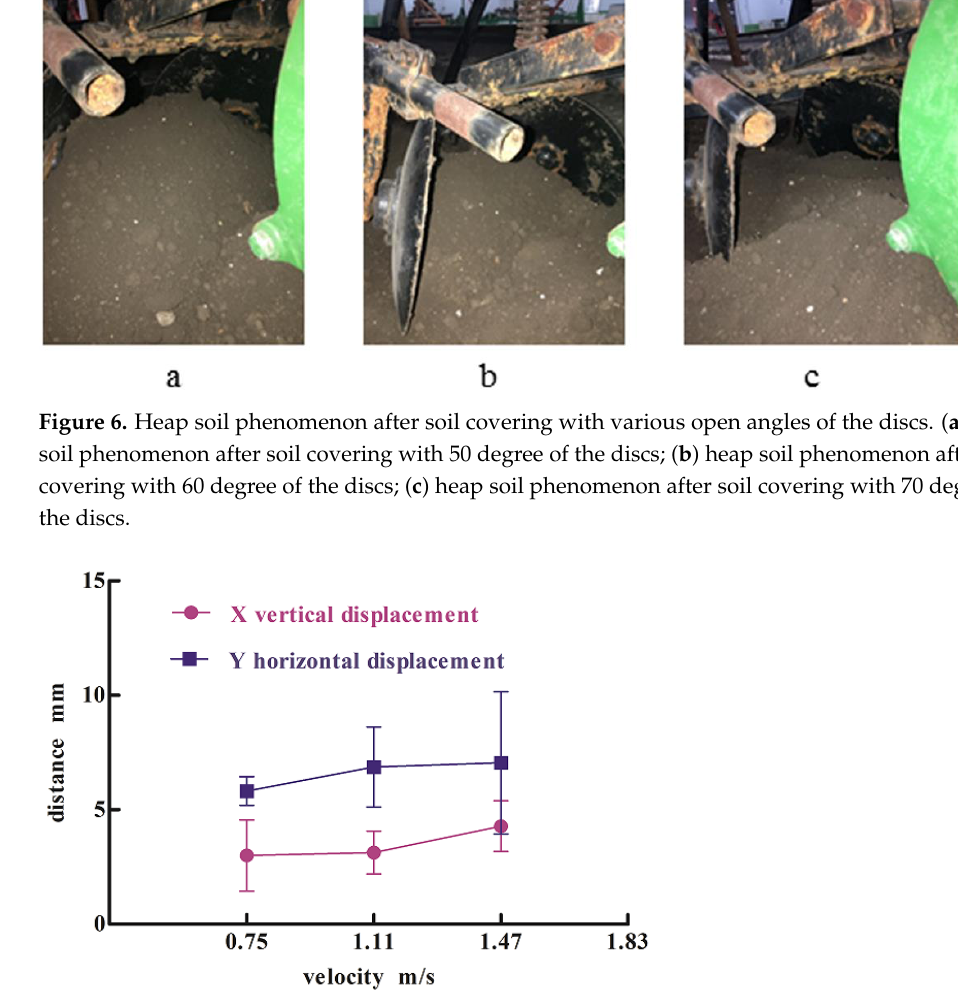
Figure 7. The influence of the soil compacting processing on the changes in seed displacement with various forward velocities.